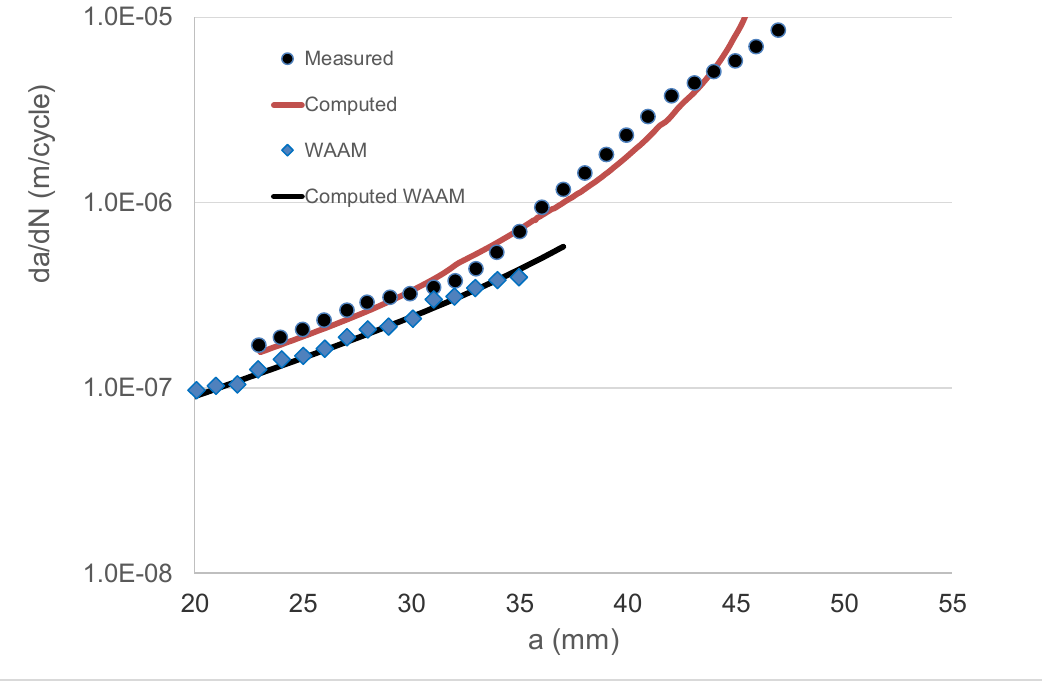
Figure 14. Comparison between the measured and computed growth rate (da/dN) versus crack length ( a ) curves for the Type C specimens.